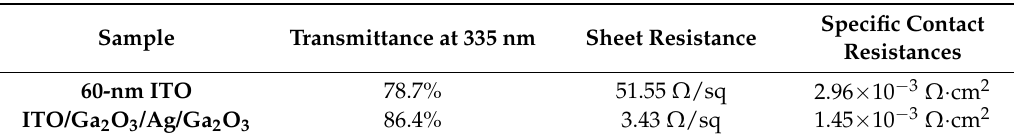
Figure 7. ( a ) Transmittances, ( b ) Energy bandgaps, and ( c ) I - V characteristic curves of the 60-nm ITO and the ITO/Ga 2 O 3 /Ag/Ga 2 O 3 multilayer. Table 4. Transmittance at 335 nm and sheet resistance of the 60-nm ITO and ITO/Ga 2 O 3 /Ag/Ga 2 O 3 on quartz